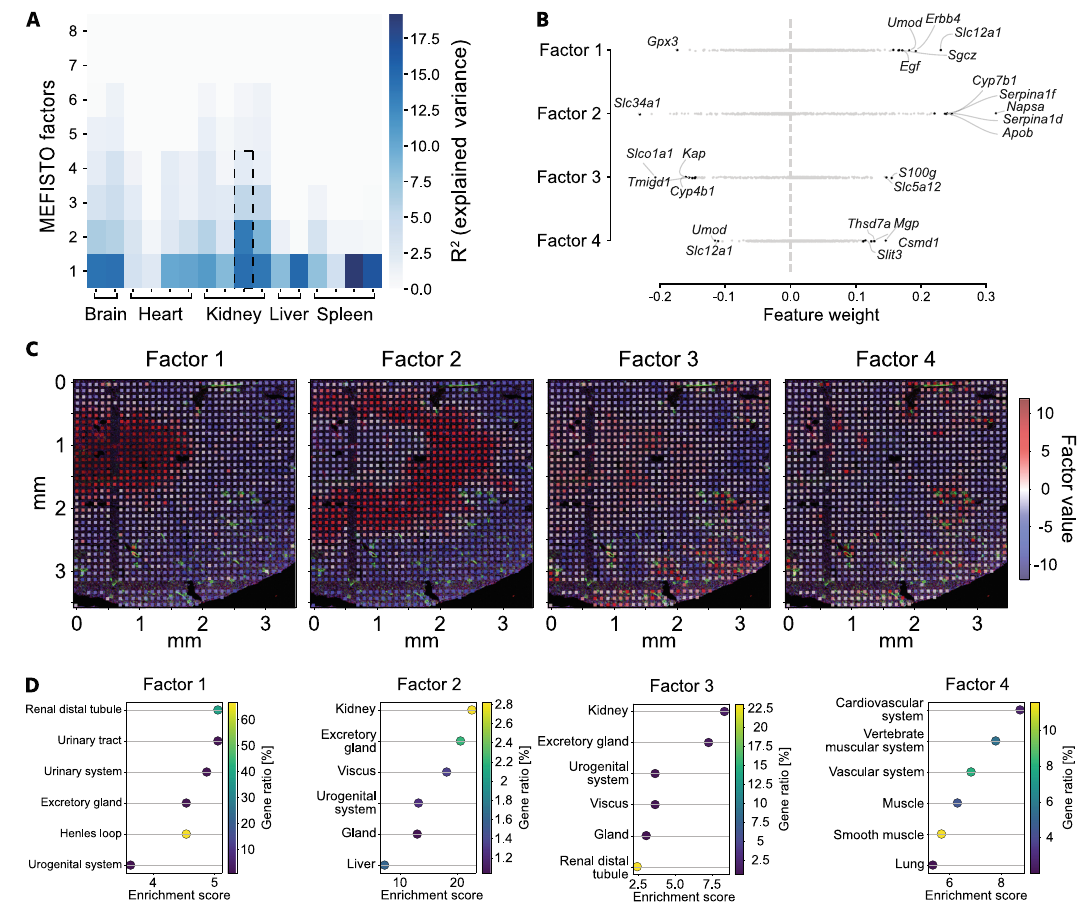
Fig. 4 | Spatial pattern analysis on xDBiT spatial transcriptomic data using MEFISTO factor analysis. A Results of MEFISTO factor analysis of all individually analyzed xDBiT datasets 38 . The heat map shows the percentage of explained var- iance(R 2 ) for the fi rst 8 factorsofeach xDBiT replicate. Dotted frame indicatesthe representative kidney sample which was selected for downstream analysis in B – D . B Scatter plot showing the weight of all genes for the fi rst four MEFISTO factors in the representative sample. Genes with the highest positive or negative weights are